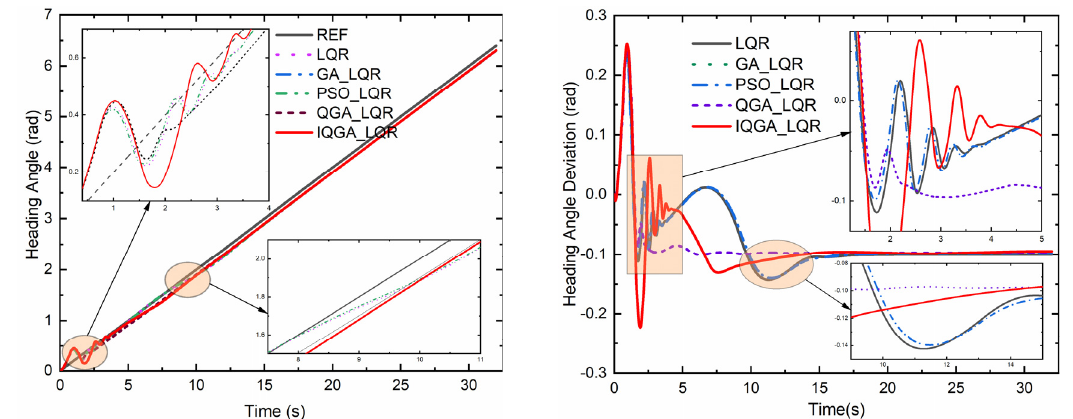
Figure 7. Heading angle and deviation.